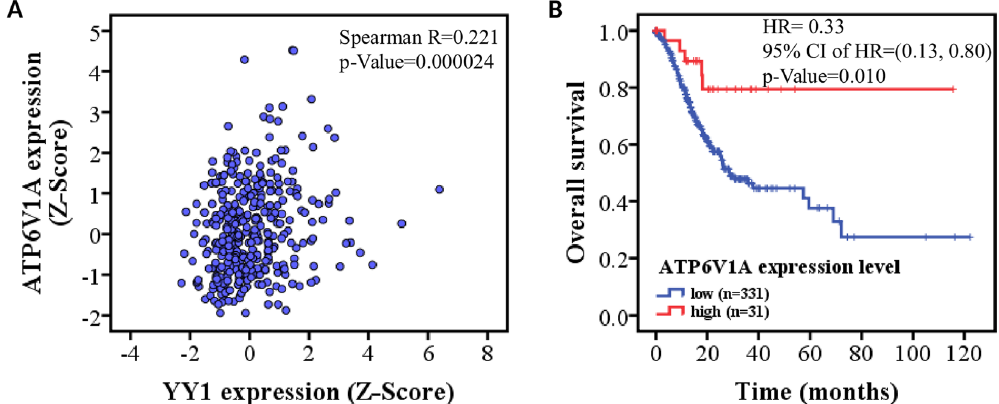
Figure 6. The correlation of ATP6V1A expression with YY1 and prognosis in gastric cancer. ( A ) The expression levels of ATP6V1A are positively correlated with those of YY1 in gastric cancer. Through analysis of YY1 and ATP6V1A mRNA expression in GC tissues of 369 individuals in the TCGA dataset, a significant correlation (Spearman correlation coefficient R = 0.221, P = 0.000024) was observed. ( B ) The prognostic value of ATP6V1A expression for GC patients was shown with the Kaplan-Meier analysis of the TCGA dataset, which indicated that a high level of ATP6V1A favors good prognosis in GC